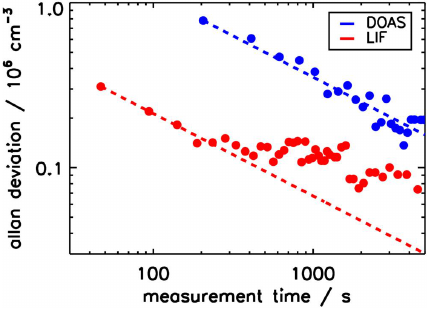
Fig. 2. Allan deviation (1 σ precision) of measurements by DOAS and LIF. Calculations include measurements that were acquired in the clean, dark chamber, before the roof was opened. For the LIF instrument, only data are included after optimization of the instru- ment’s background signal (see text for details). Lines give the trend in the Allan deviation, which would be expected if measurements were distributed like Gaussian noise (inverse square-root depen- dence on the measurement